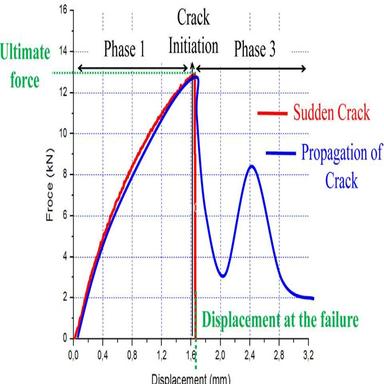
Force vs. displacement responses for pure opening mode (a) ψ = 0∘ , pure shear mode (b) ψ = 90∘ and mixed opening/shear mode (c) ψ = 30∘ , (d) ψ = 45∘ , (e) ψ = 60∘ .